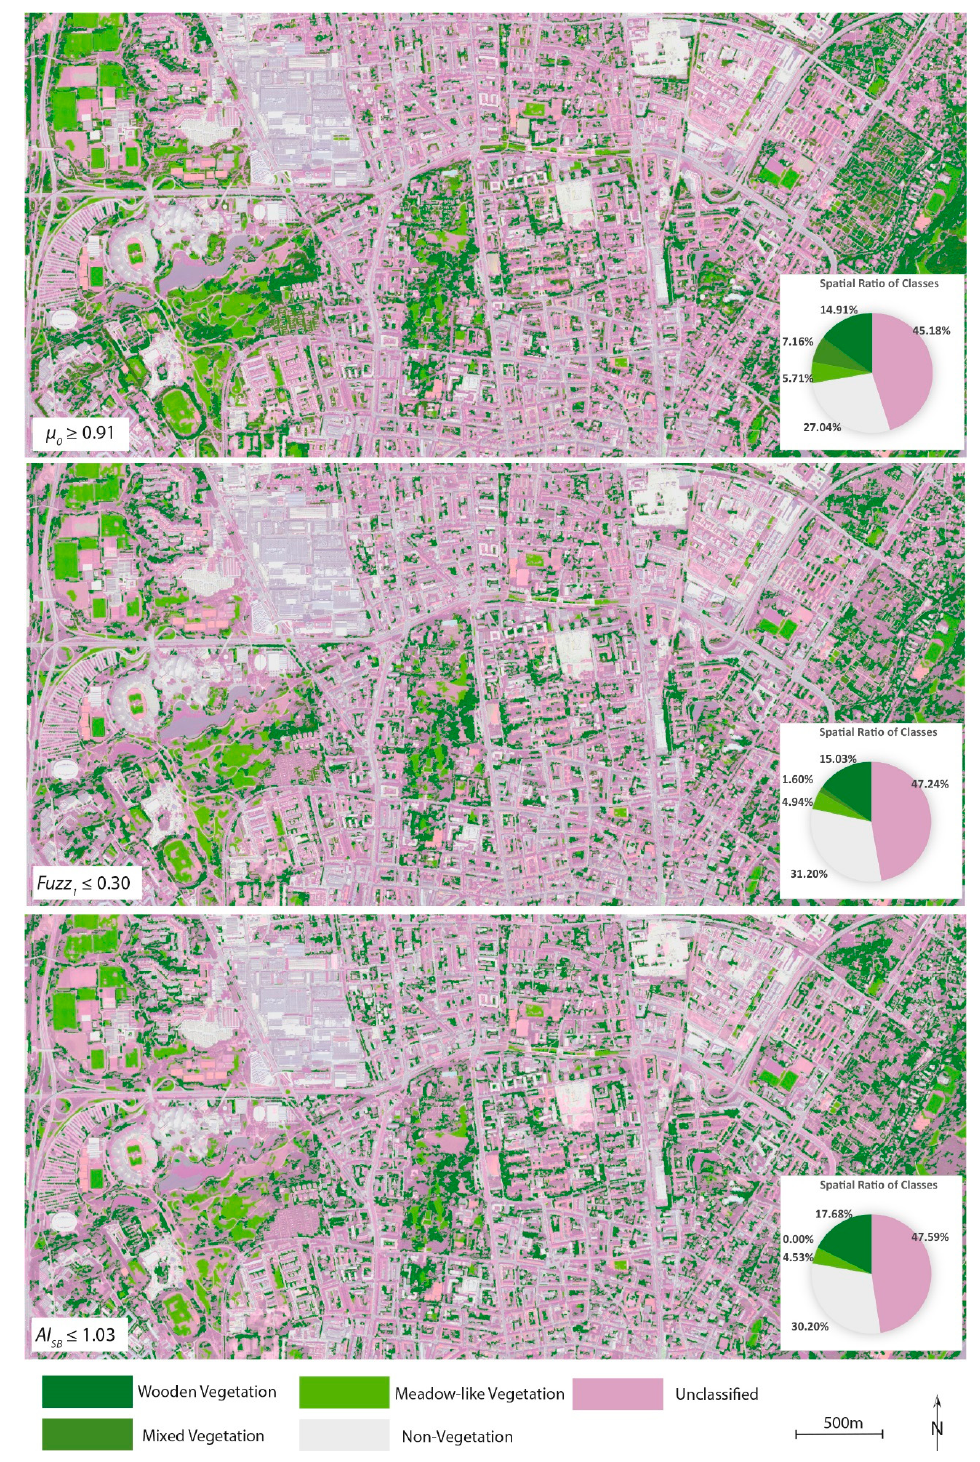
Figure 9. Crisp classification results after defuzzifying fuzzy classified objects of a WV-2 scene of Munich by applying the median for each measure as defuzzification rules ( µ 0 ≥ 0.90, Fuzz 1 ≤ 0.30 and AI SB ≤ 1.03) and their respective area